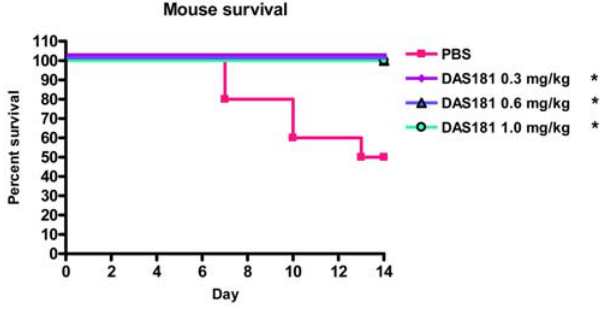
Figure 4. DAS181 inhibits pandemic IFV A(H1N1)-induced lethality in mice. BALB/c mice were inoculated with the pandemic influenza A(H1N1) virus A/Mexico/4108/2009 (1000 MID 50 /mouse, i.n. ). The mice were treated with PBS or DAS181 (0.3, 0.6, or 1 mg/kg) q.d.x5 , beginning 6 hours post-infection. Survival was tracked daily for 14 days. Values represent percent survival amongst 10 mice per group. All DAS181 treated groups had 100% survival. Statistical significance from PBS determined by Kaplan-Meier Log Rank Test, *=p , .05.